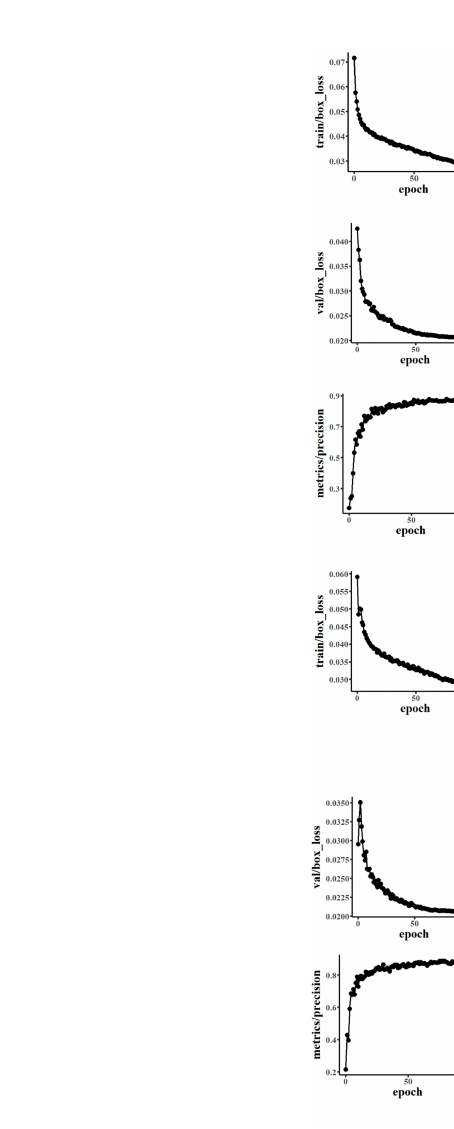
FIGURE 6 Graph of the You Only Look Once model training results (Train/val box_loss: the bounding box loss of the training dataset or validation dataset; the smaller the box is, the more accurate. Train/val obj_loss: train or val is speculated to be the mean loss of the target detection, and the smaller the target detection is, the more accurate the detection. Train/val cls_loss: train or validation is speculated to be the mean of classi fi cation loss, and the smaller the classi fi cation is, the more